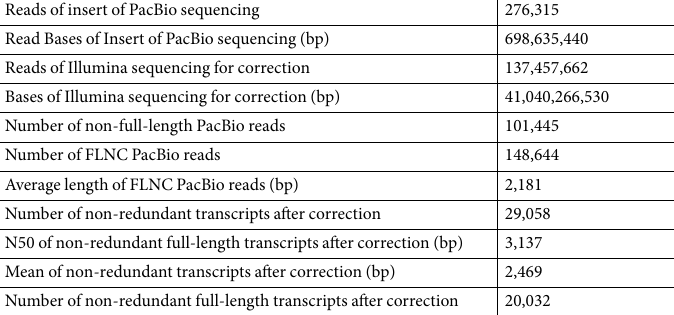
Table 1). We used an isoform-level clustering algorithm, Iterative Clustering for Error Correction (ICE) 12 , to improve